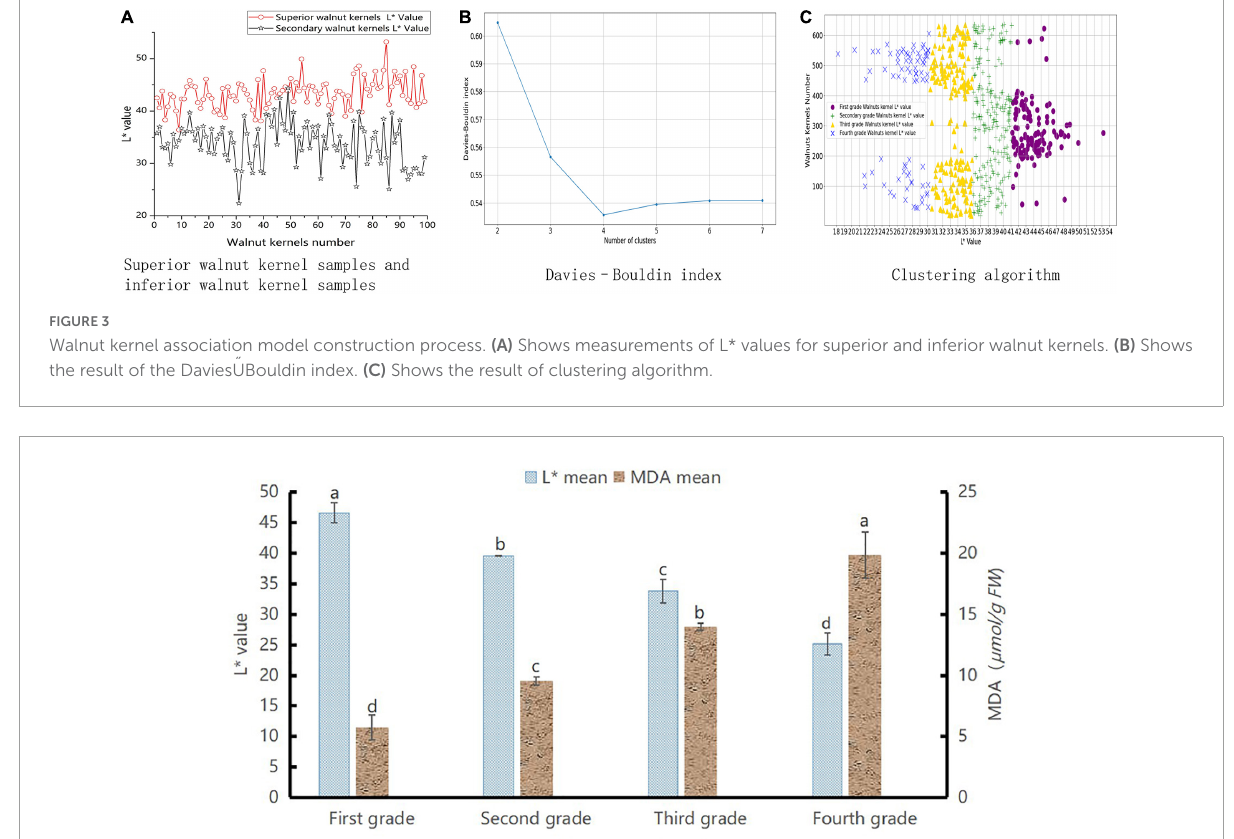
walnut kernels were graded as follows: grade I (41, 54); grade